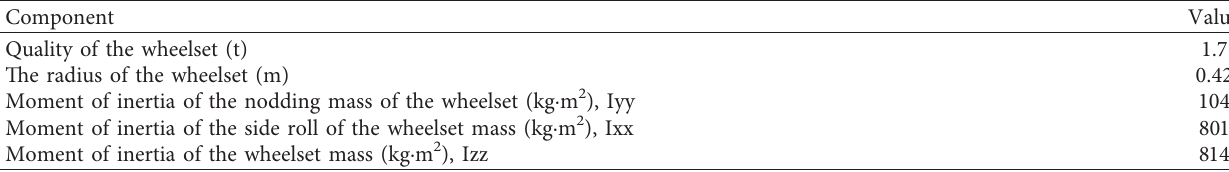
Table 3: Parameters of the wheelset.